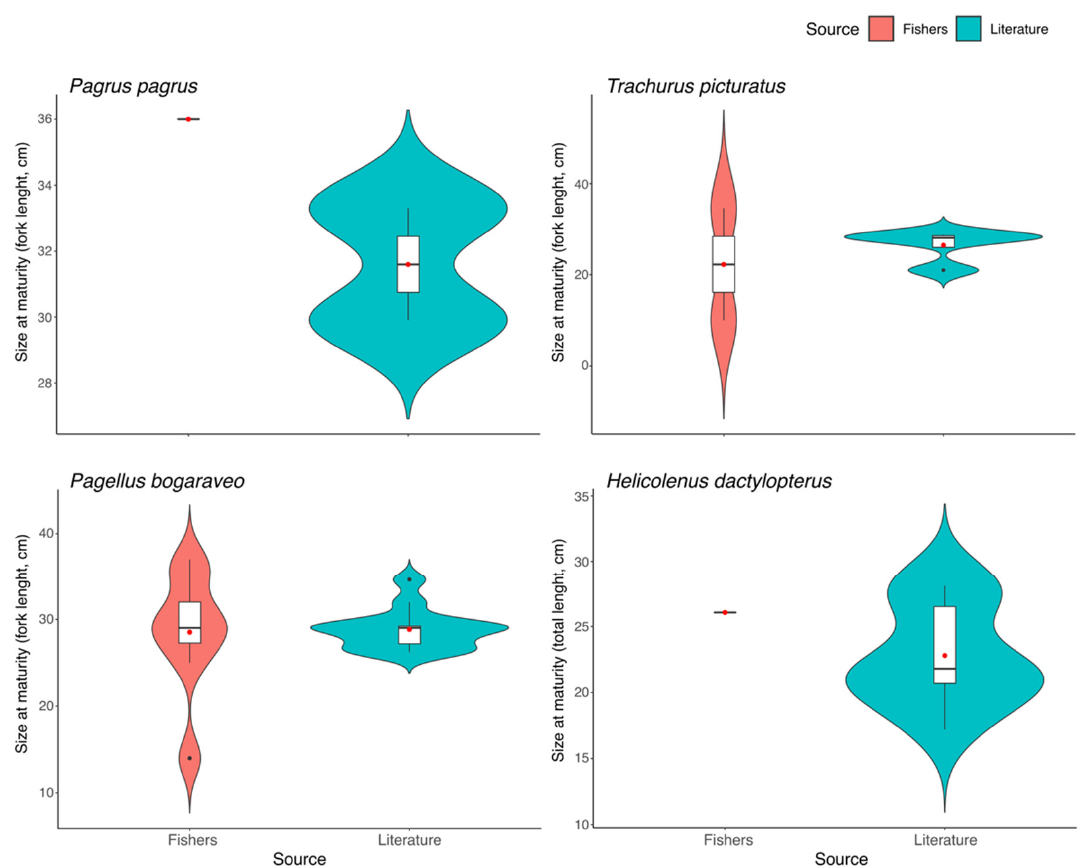
Figure 3. Size at maturity (cm) of the species studied in the Azores according to fishers’ experiential knowledge and obtained from scientific literature [32]. Line inside the box represents the median, the box represents the interquartile range, the curves indicate the kernel probability density of the data at different values, and the red point represents the mean value. P. pagrus (no. of fishers’ responses = 1), T. picturatus ( n = 2), P. bogaraveo ( n = 8), H. dactylopterus ( n = 1).